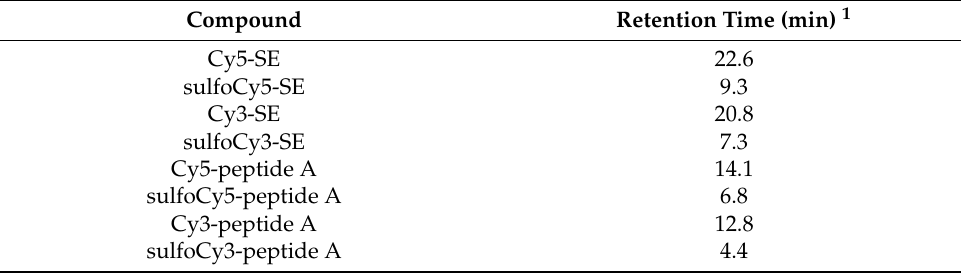
Table 1. Retention times of dye-SE and dye-peptide A conjugates.